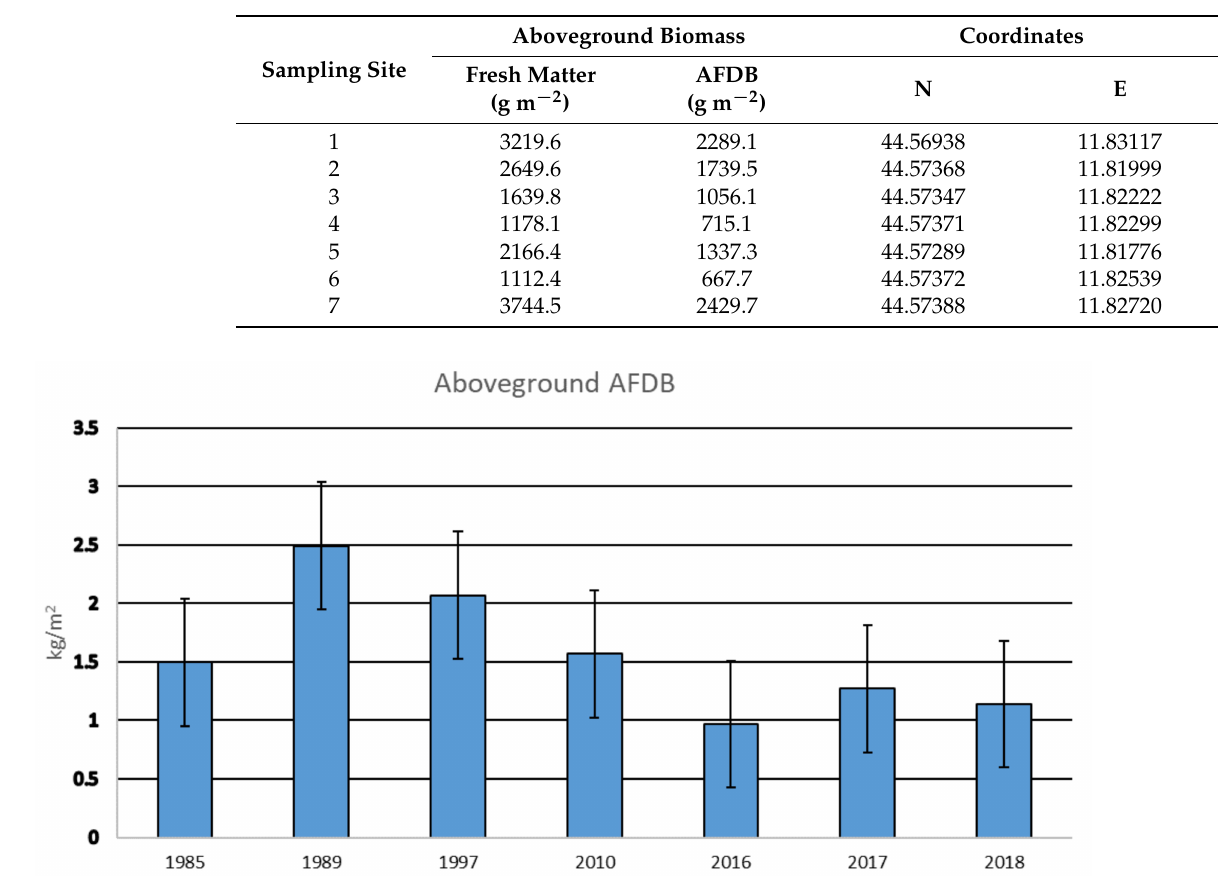
Figure 2. Estimates of aboveground ash free dry biomass (AFDB) per m 2 ( ± st.err.) over time (1985–2018) for each considered year.